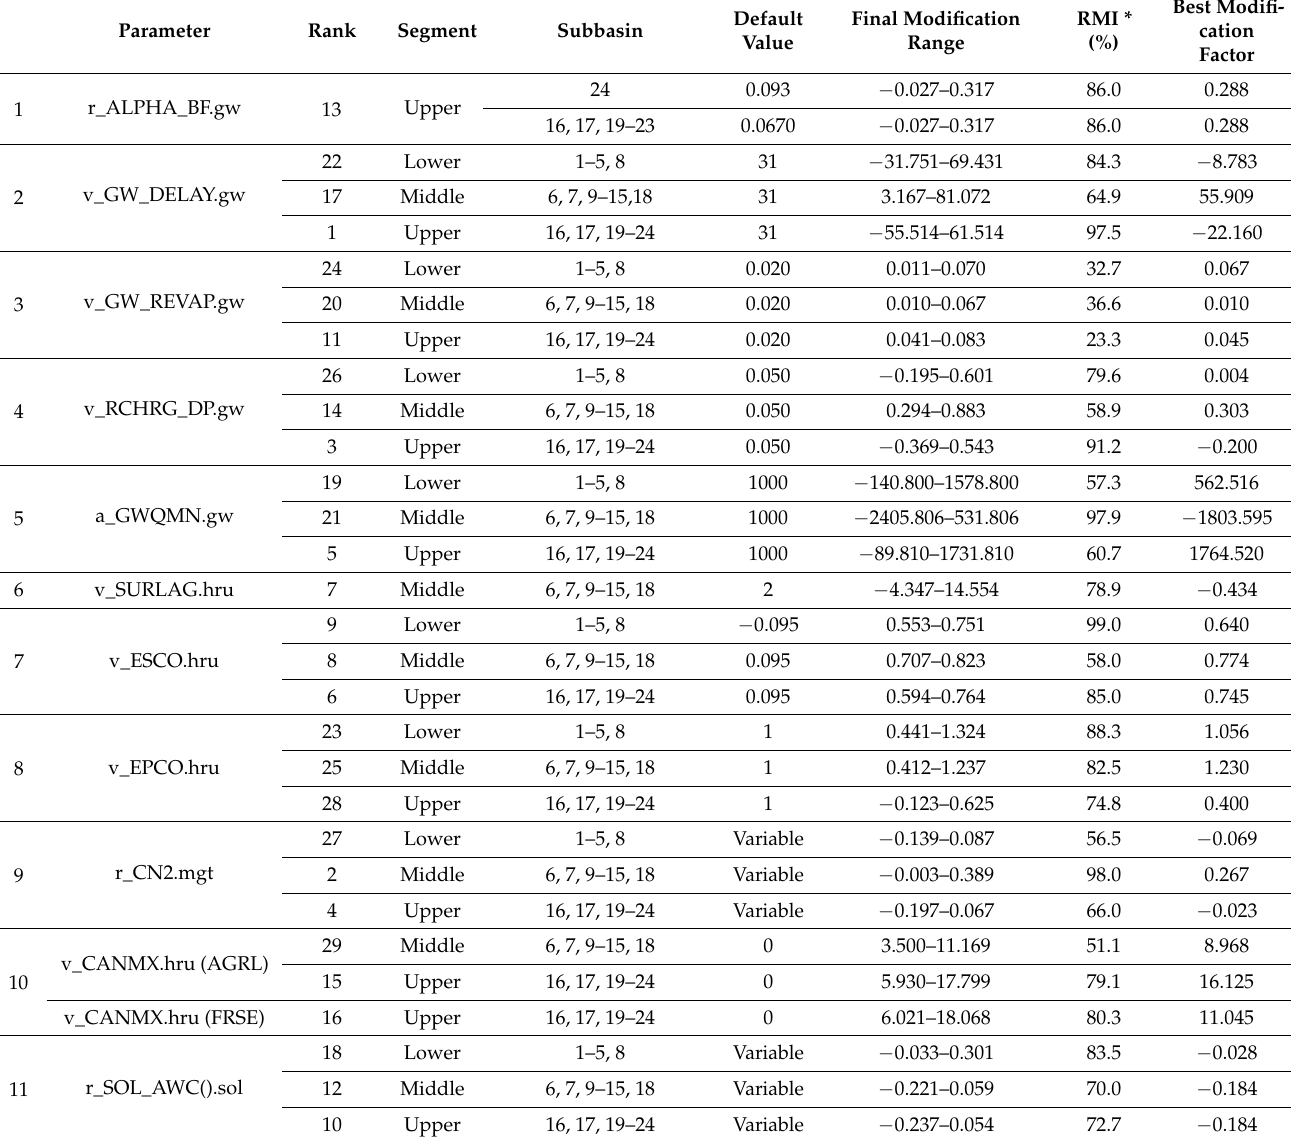
Table 3. Parameters used during calibration on SWAT-CUP and its rank based on sensitivity anal- ysis. Initial values during model setup, final modification range from the best iteration and best modification factor, and remaining modification interval (RMI) regarding the best simulation are also